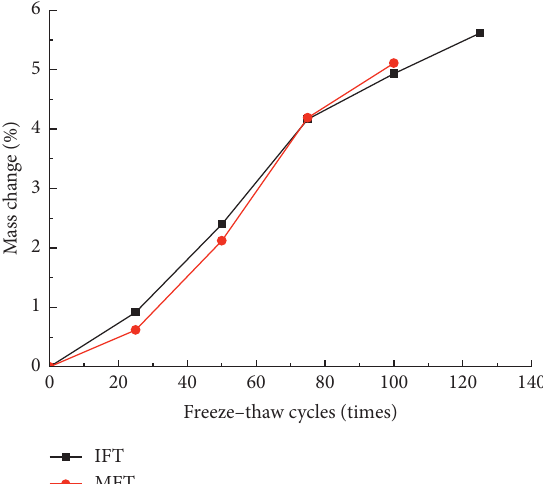
Figure 3: Variations of relative mass change of concrete specimens with freeze–thaw cycles in IFT and MFT environments.